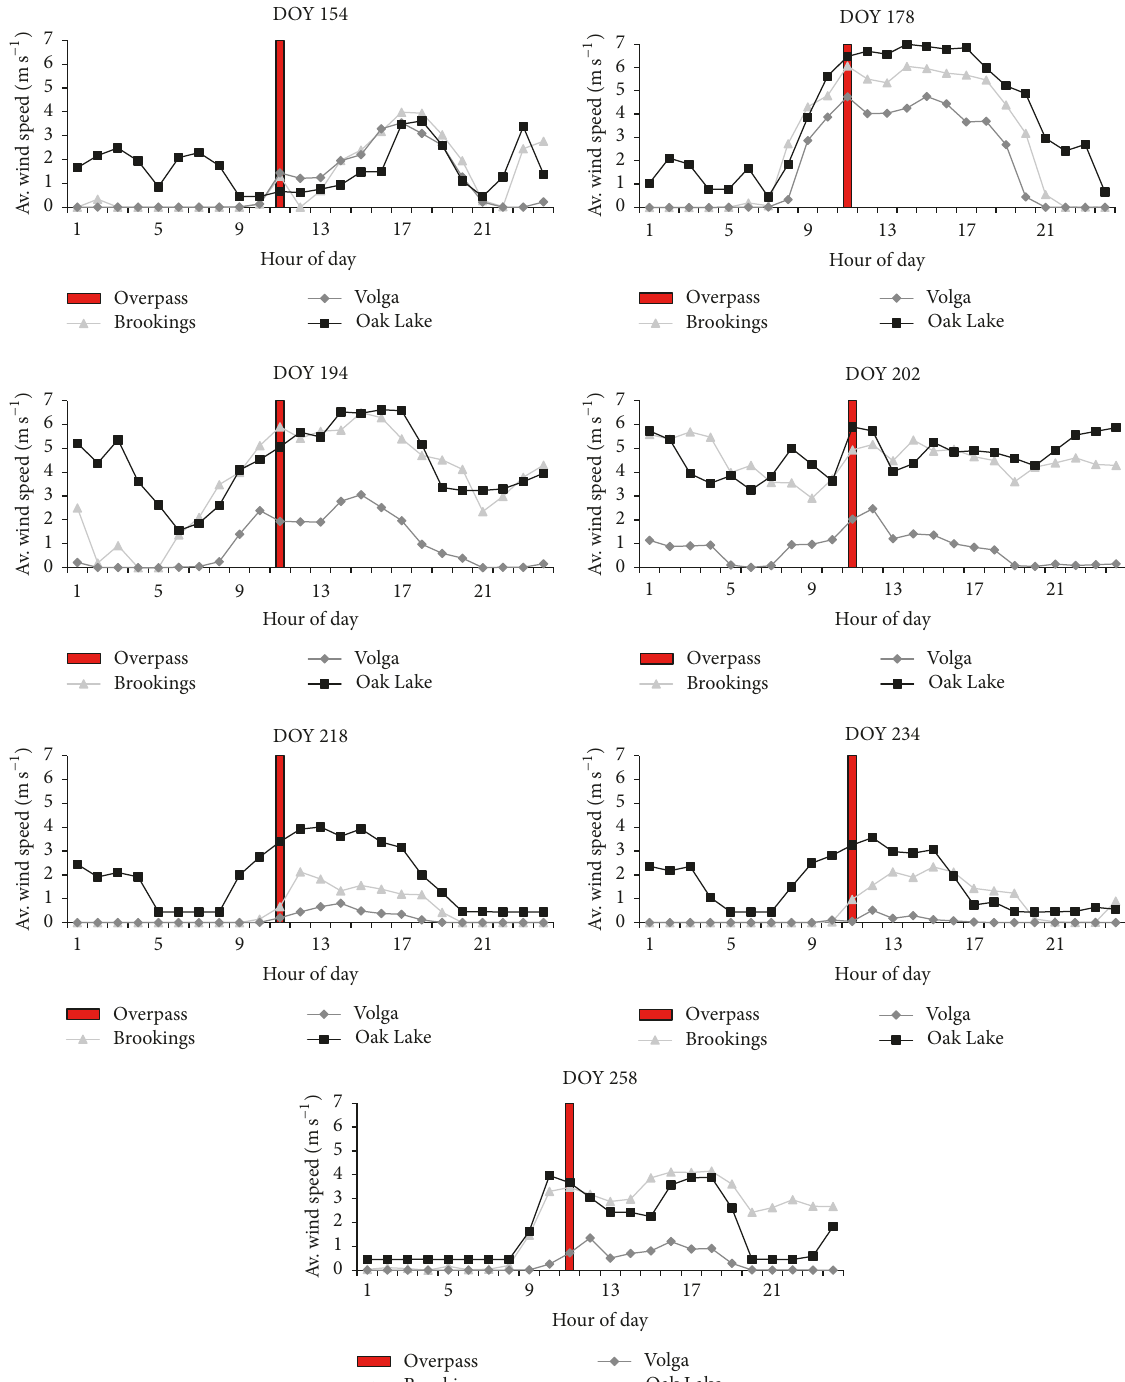
Figure 12: Hourly average wind speed values at three sites in eastern South Dakota. The red columns denote the time of satellite overpass ( ± 11:12